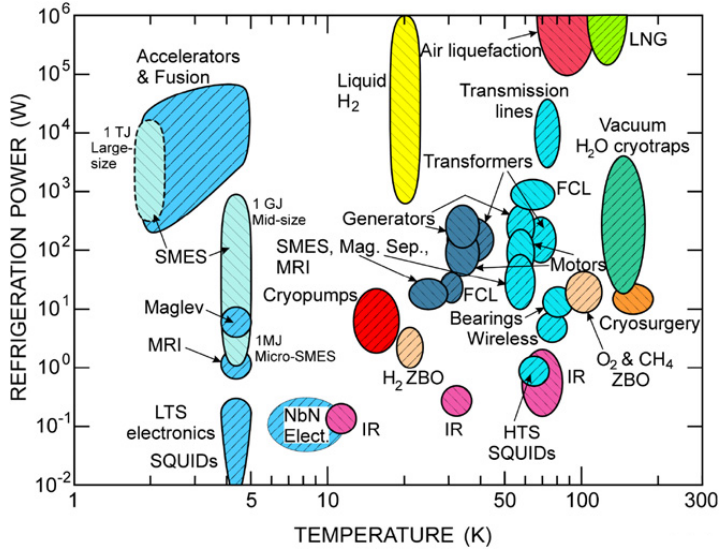
Figure 4. Map of cryocooler applications in the plane of refrigeration power versus temperature